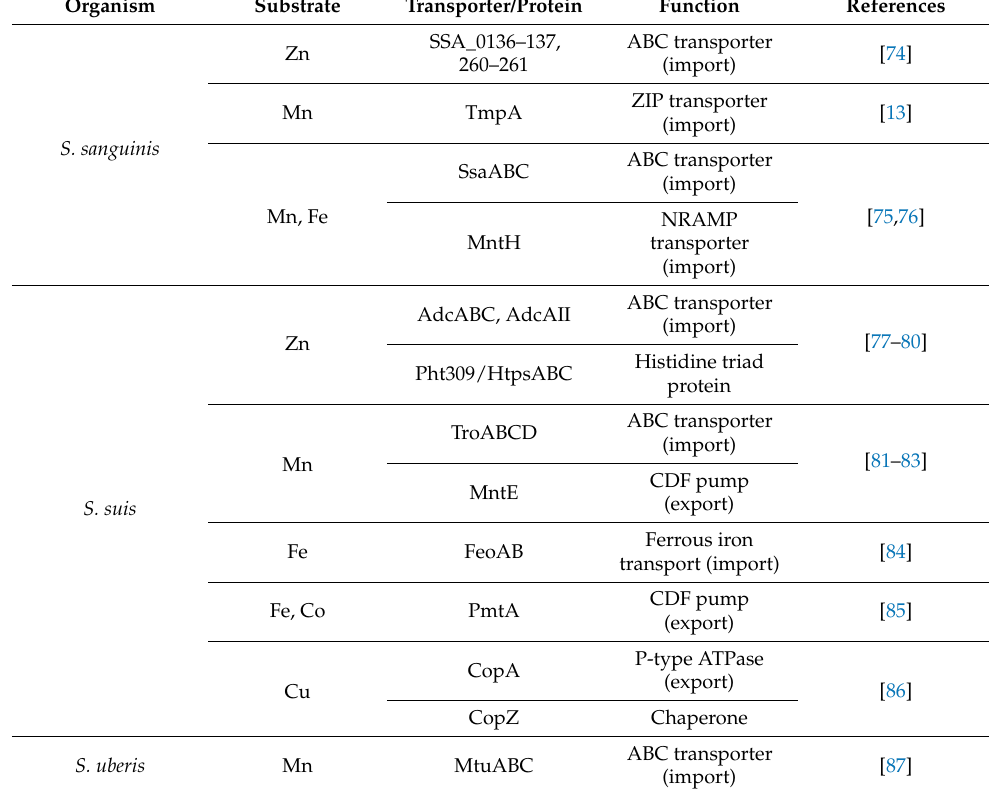
Table 2. Cont. Organism Substrate Transporter/Protein